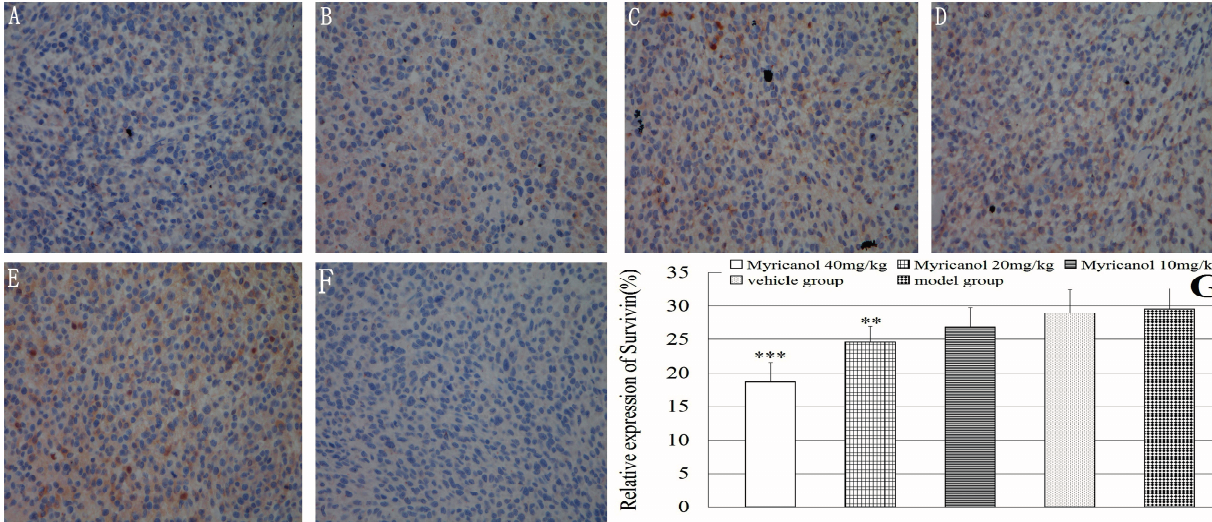
Figure 7. Immunohistochemical detection of survivin protein in A549 cells (magnification of 400×). The relative expression of survivin was determined by NIS-Elements D 3.2 image analysis system. ( A ) Myricanol with 40 mg/kg; ( B ) myricanol with 20 mg/kg; ( C ) myricanol with 10 mg/kg; ( D ) vehicle control group; ( E ) tumor model group; and ( F ) isotype control; ( G ) Quantification of protein expressions in different groups with IHC. ** p < 0.01, *** p < 0.001 vs. vehicle